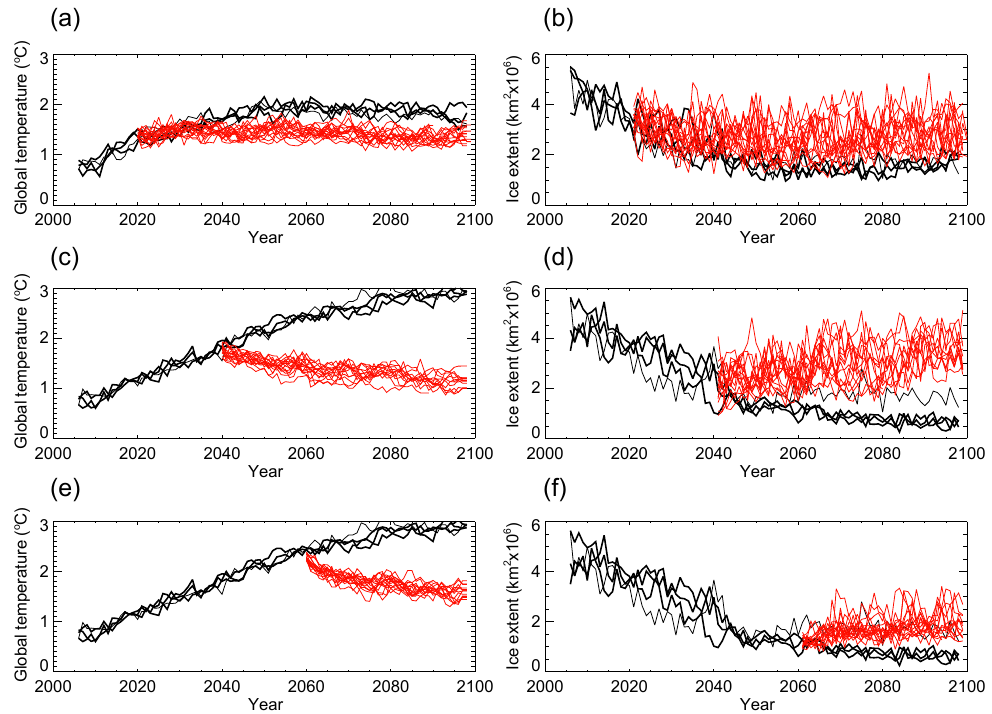
Figure 1. (a) Global mean 1.5m temperature and (b) Arctic sea ice extent for the four ensemble RCP2.6 simulations (black) and the 16- member Ensemble 1 initiated from + 1.5 ◦ C (red). (c) Global mean 1.5m temperature and (d) Arctic sea ice extent for the four ensemble RCP4.5 simulations (black) and the 16-member Ensemble 2 initiated from + 2 ◦ C (red). (e) Global mean 1.5m temperature and (f) Arctic sea ice extent for the four ensemble RCP4.5 simulations (black) and the 16-member Ensemble 2 initiated from + 2.5 ◦ C (red).